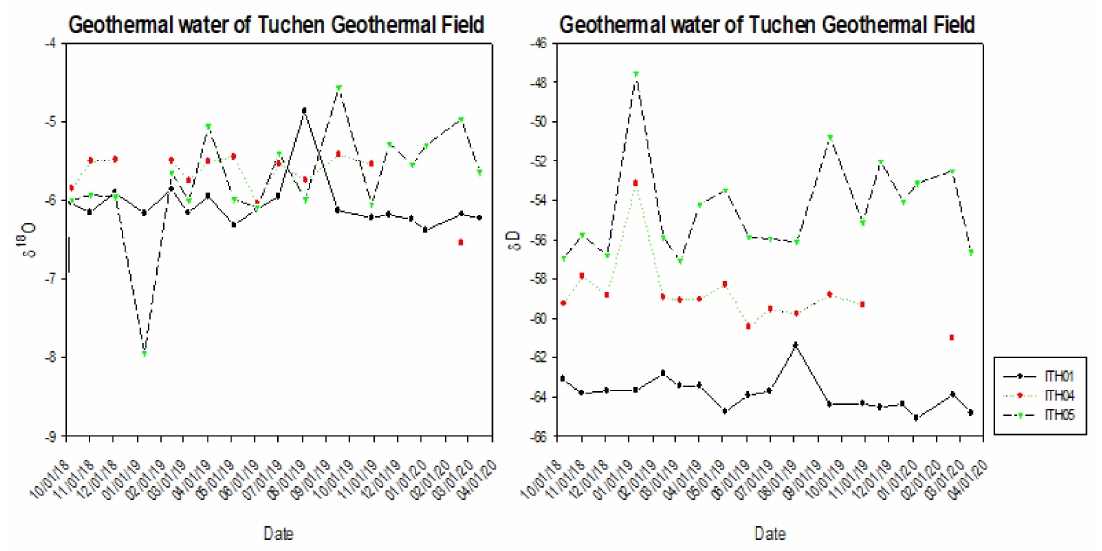
Figure 6. Time series of δ 18 O and δ D variations of thermal water in the study area. δ 18 O values of Wells ITH01, 04, and 05. ITH03 data are presented in Figure 4 with surface water due to its similar behaviors to surface